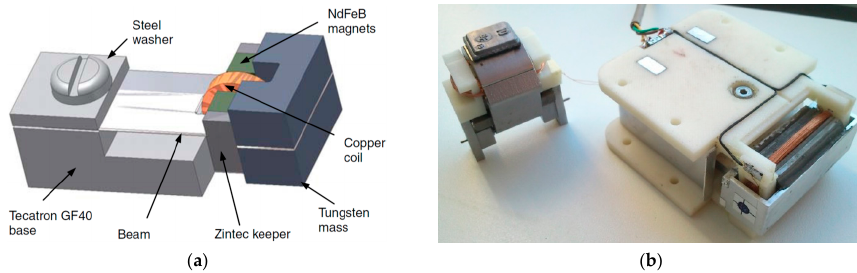
Figure 11. Miniaturized electromagnetic vibration EH devices proposed in [97] ( a ) and two versions of the ESPOSA EH devices [101] ( b ).